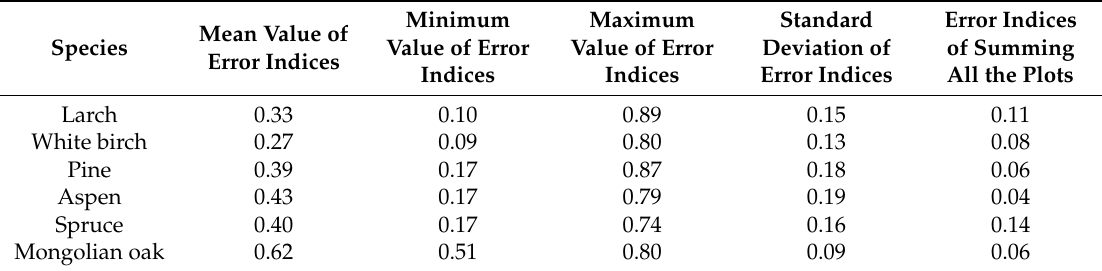
Table 4. Error indices of DBH distributions for each species in all plots based on the WPPMs using LOOCV method.